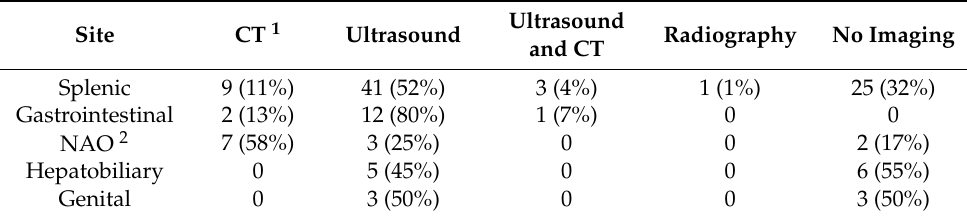
Table 1. Type of imaging applied to abdominal masses in dogs. N (%). Site CT 1 Ultrasound